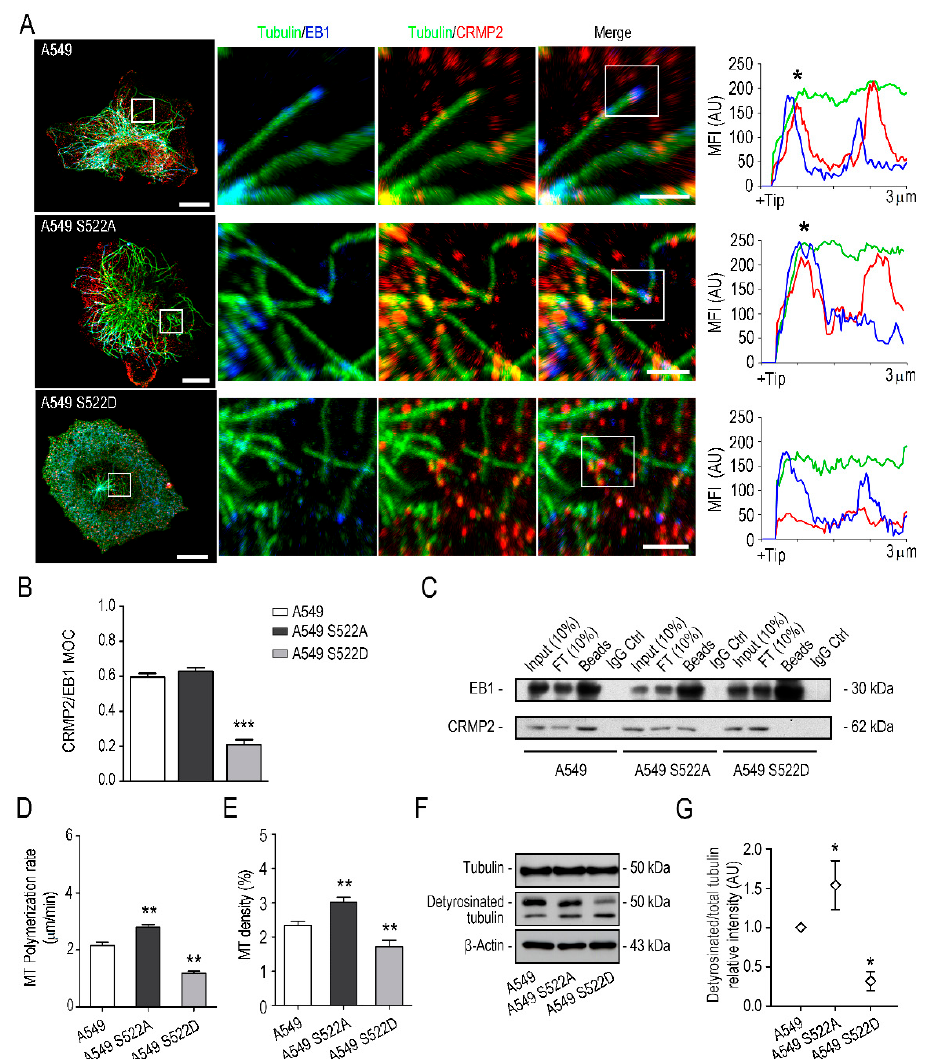
Figure 6. CRMP2 phosphorylation in Ser522 affects binding to EB1 and microtubule stability. ( A ) Representative maximum intensity projections of confocal images of the control cell line A549 and the A549 S522 clones stained with anti-tubulin (green), anti-CRMP2 (red), and anti-EB1 (blue) antibodies 4 h after nocodazole treatment (10 µ M) followed by serum stimulation. Scale bar = 10 microns. White inserts show enlarged areas of the +TIP of individual microtubules. Scale bar = 5 microns. Representative fluorescence intensity profiles on the right show strong co-localization between CRMP2 and EB1 (black asterisks) in the first 3 microns of the +TIP of a single microtubule; ( B ) Manders’ overlap coefficient (MOC) between tubulin and EB1 positive signal from images shown in ( A ). (Number of images, n = 50); ( C ) immunoprecipitation of CRMP2 and EB1 proteins from extracts obtained from A549 wild-type and A549 cells expressing the CRMP2 mutants. (Number of blots, n = 3); ( D ) quantification of MT polymerization rate in the different cells after nocodazole treatment (10 µ M, 4 h) and subsequent stimulation in 10% serum for 1-, 3-, 5-, 10-, and 20 min. Data are shown as mean MT length per time ( µ m/min). (Number of cells, n = 150 per time point); ( E ) quantification of MT density in cells treated as in ( D ). Data are shown as the area of tubulin signal relative to the area of the cell. (Number of cells, n = 50 per time point). ( F ) Western blot analysis of tubulin and detyrosinated tubulin protein expression in CRMP2 S522 clones. β -Actin was used as a Western blot loading control. (Number of blots, n = 3); ( G ) quantification of tubulin and detyrosinated tubulin expression levels from total protein extracts shown in ( F ) (arbitrary units, AU). Each sample was normalized to β -Actin expression and, referred, to the expression of tubulin in the A549 control cell line. *** ( p < 0.001). ** ( p < 0.01). * ( p <